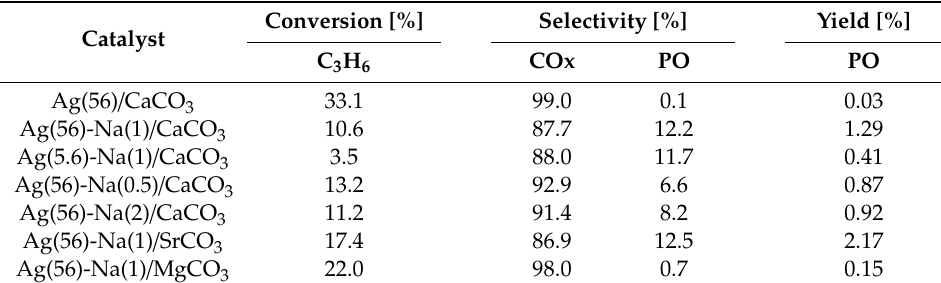
Table 4. Catalytic activities on various Ag-Na / MCO 3 (M = Ca, Sr, or Mg).